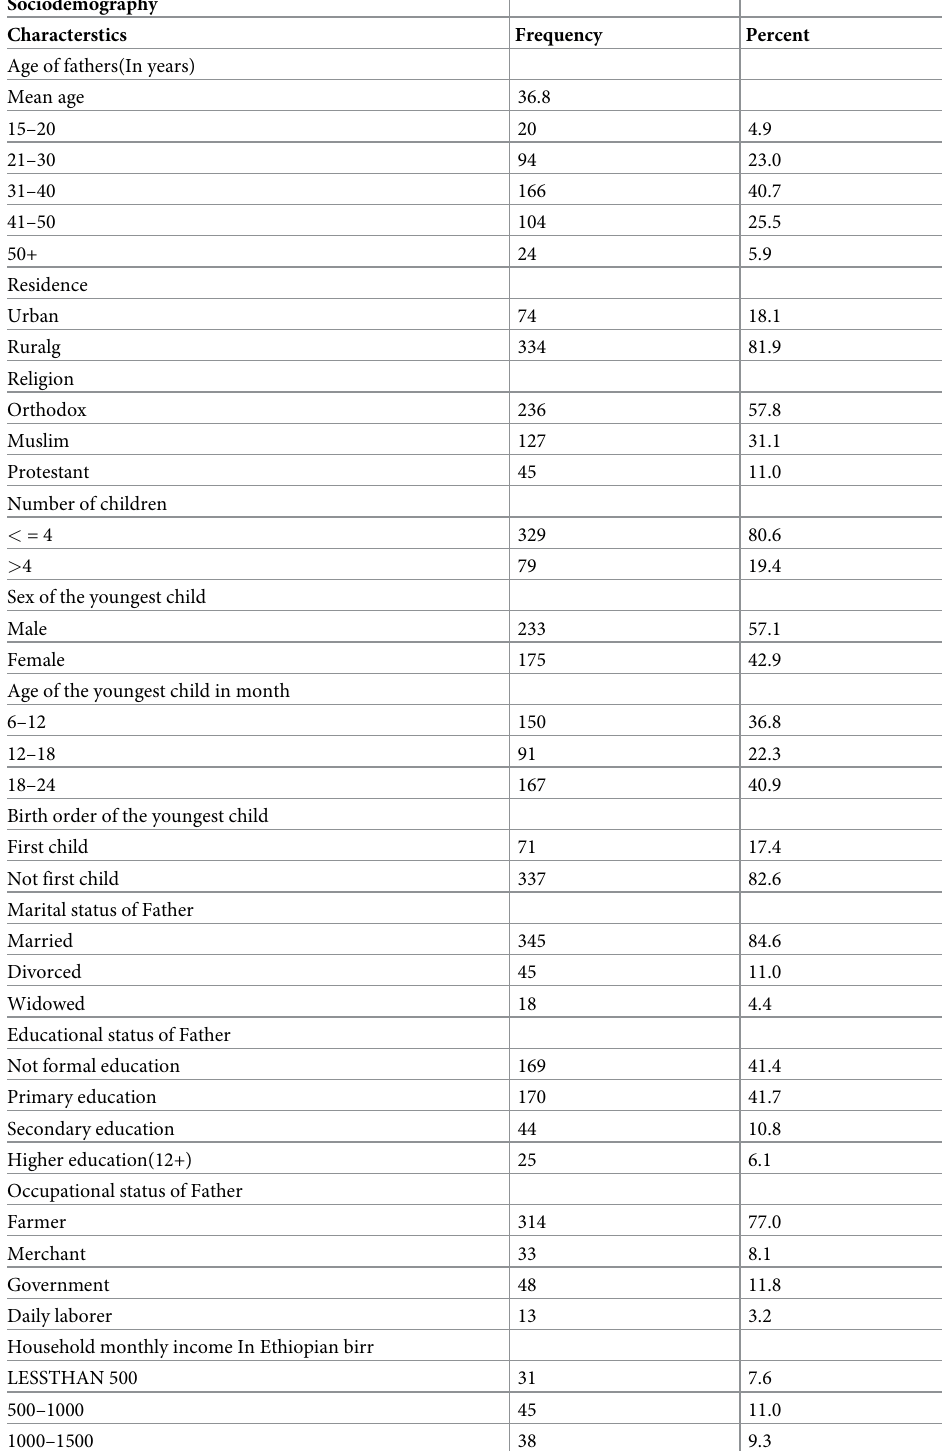
Table 1. Socio-demographic characteristics of father involvement in child feeding among fathers who had chil- dren aged from 6–24 months in Antsokia Gemza Woreda,2022 (n =